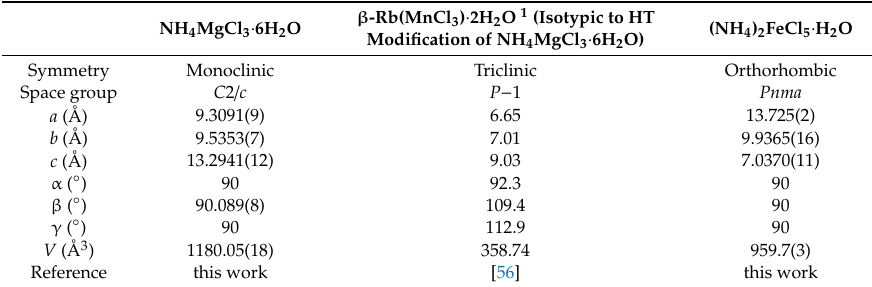
Table 8. Crystallographic data used as starting models for the refinement of NH 4 MgCl 3 · 6H 2 O, its HT phase and of the (NH 4 ) 2 FeCl 5 · H 2 O phase by the Rietveld